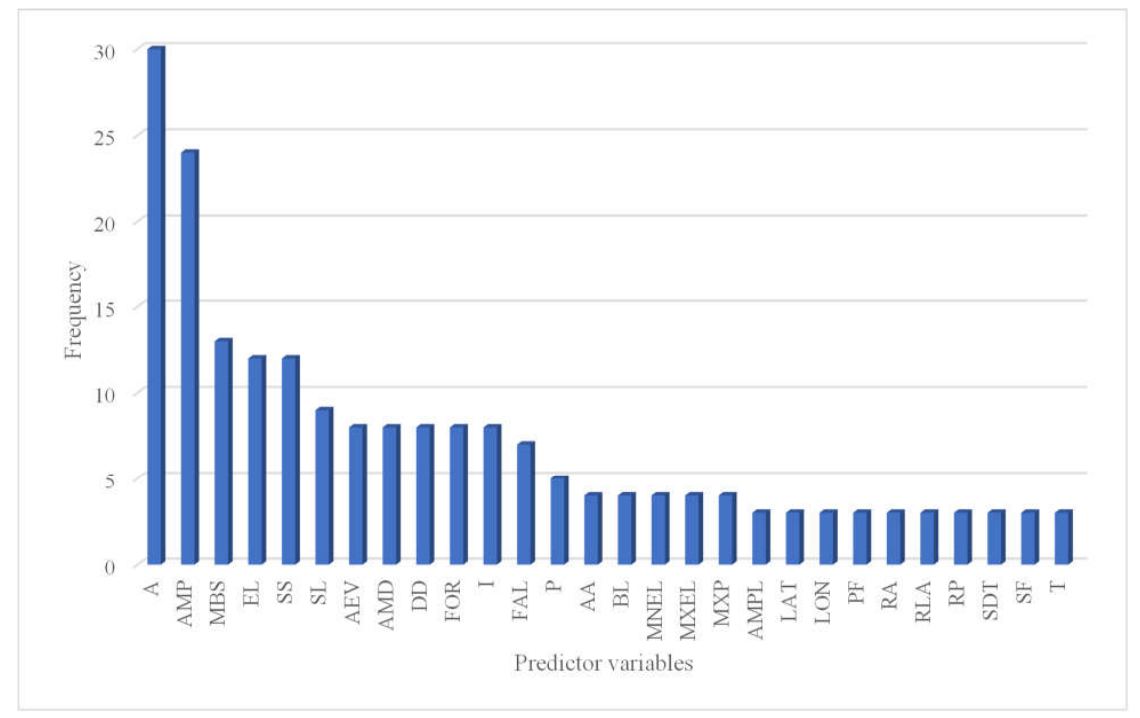
Figure 4. Predictor variables used in flood estimations.